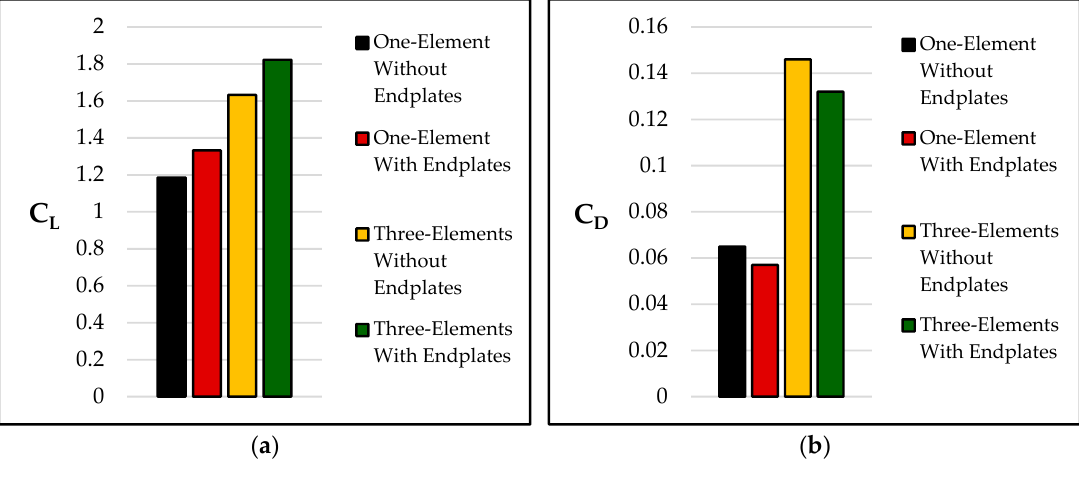
Figure 7. Pressure distribution in baseline configurations at sections: ( a ) 0.05 s; ( b ) 0.95 s.